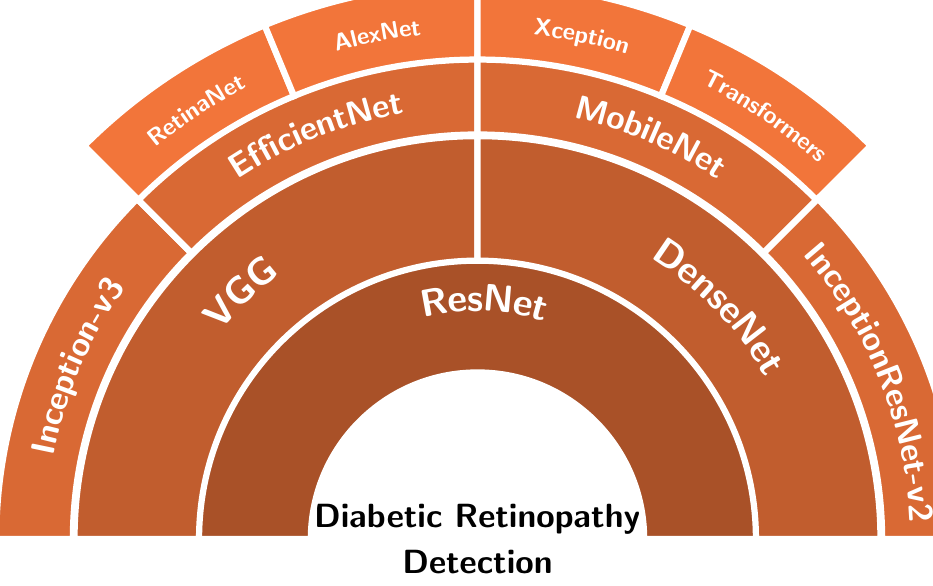
Figure 3. Backbones used for diabetic retinopathy detection